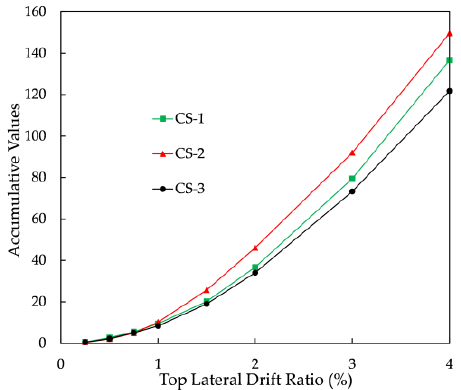
Figure 22. Comparison of accumulative values of energy dissipation (unit: kN·m).